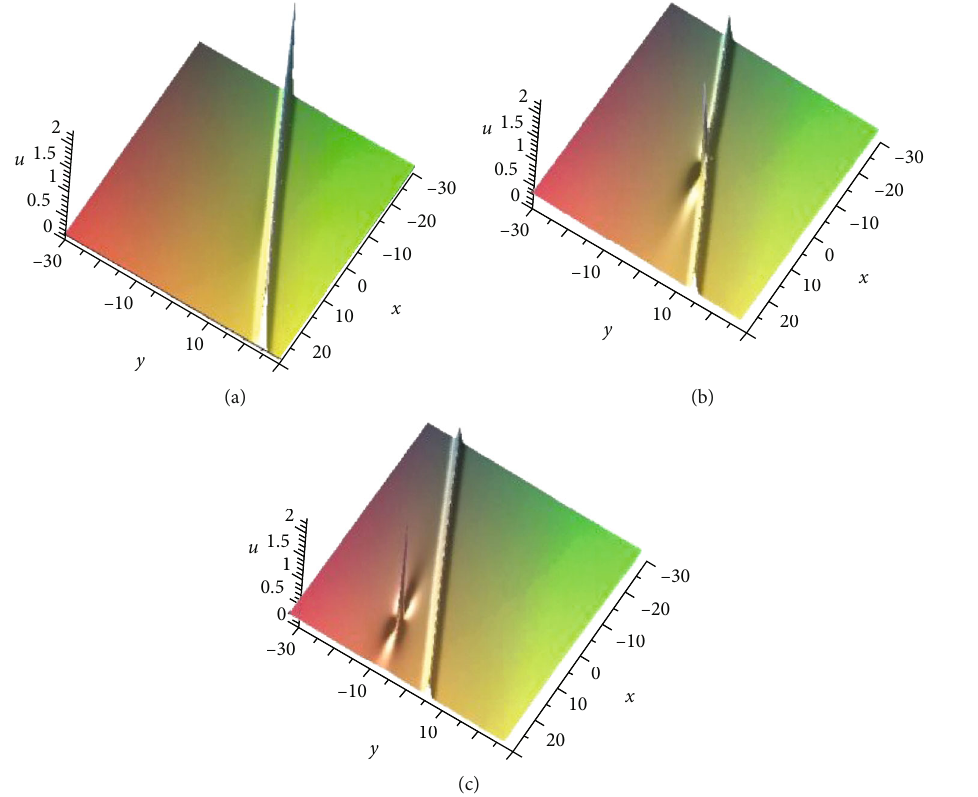
= 1 − i , q = 1 + i , a = 1 , b = 1 , τ = 0 , c Figure 4: The fundamental semirational solution (27) with p 1 1 t = − 2 , (b) t = 0 , and (c) t = 2 Figure 3, there are a line soliton and a lump at t = − 1/2 . Then, the lump travels toward the soliton and merges with the soliton at t = 0 . When t = 1/2 , the lump van- ishes completely and only the soliton exists 16 ð a + 2 b (ii) Fission: we consider the case where p 3 1 , R Þ < 0 . As t ⟶ −∞ , we obtain u ⟶ 0 , u p 1 , max min 1 I ⟶ 0 , u ⟶ 0 , which shows that the lump does min 2 not exist before it interacts with line soliton. As t ⟶ + ∞ , we have u ⟶ 64 p 4 / j p j 4 , u ⟶ max min 1 1 , R 1